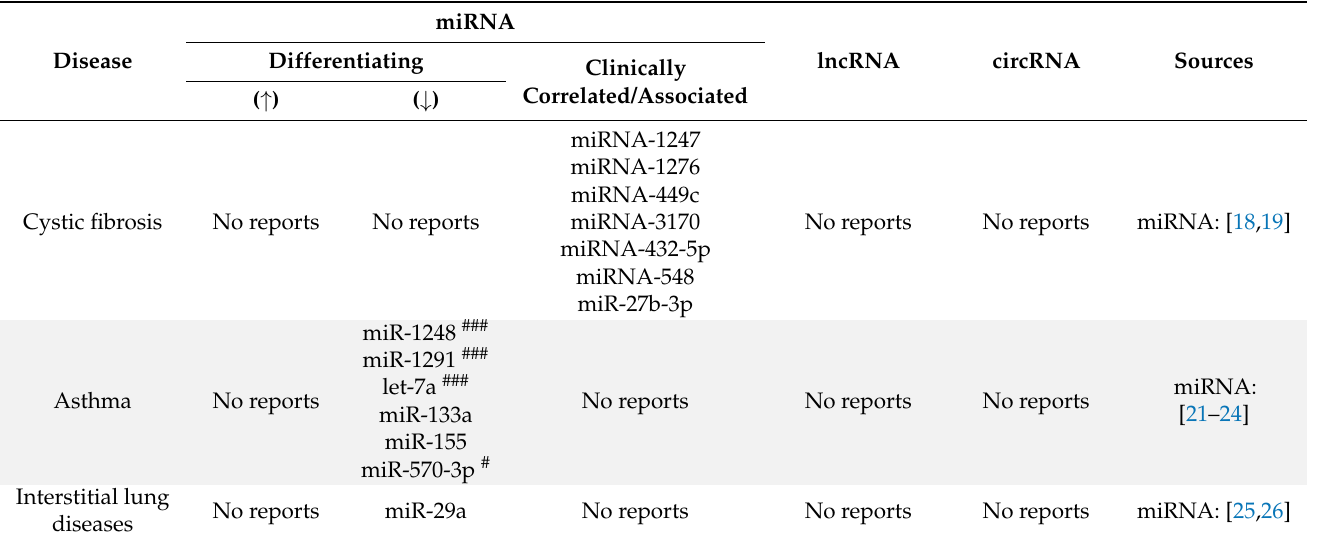
Table 1. Non-coding RNAs investigated in exhaled breath condensate (EBC) in three examples of respiratory diseases. miRNAs are classified accordingly to their reported nature as disease- differentiating or associated with the clinical parameter.